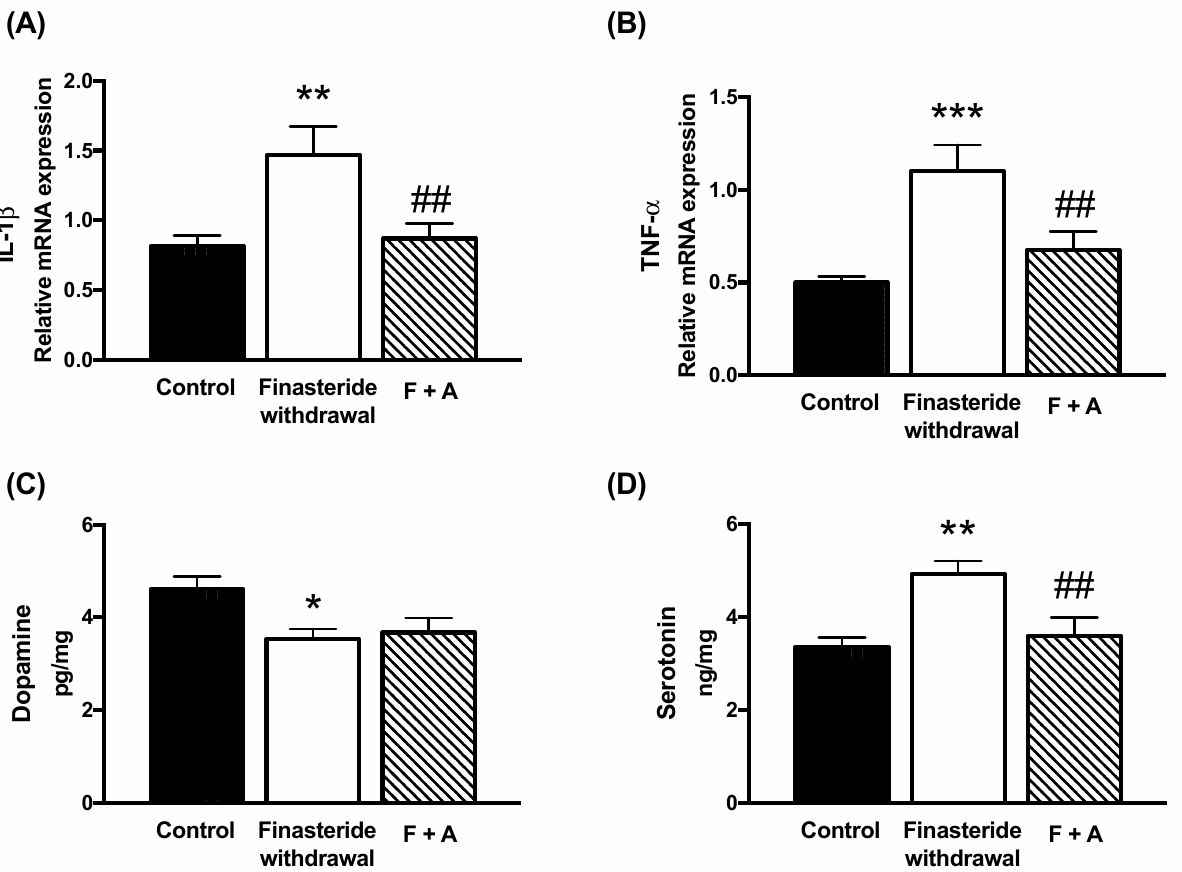
Figure 4. Gene expression of IL-1 β ( A ) and TNF- α ( B ) detected by real-time PCR in the colon of controls, finasteride-treated rats and ALLO-treated rats after drug withdrawal (F + A). The columns represent the mean ± SEM after normalization with 36B4 mRNA. Levels of dopamine ( C ) and serotonin ( D ) were detected by LC-MS/MS in the colon of controls, finasteride-treated rats and ALLO-treated rats after drug withdrawal. Data are expressed in pg/mg or ng/mg ± SEM, n = 7 for each group. The effect of treatment of ALLO was analyzed using one-way ANOVA followed by Uncorrected Fisher’s LSD post hoc test (significance: * p < 0.05; ** p < 0.01; *** p < 0.001 vs. control group; ## p < 0.01 vs. finasteride-treated rats).